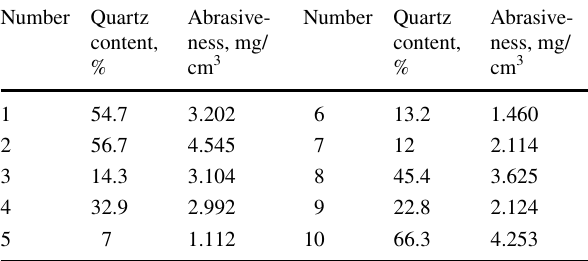
Table 2 Quartz content and abrasiveness Number Quartz content,